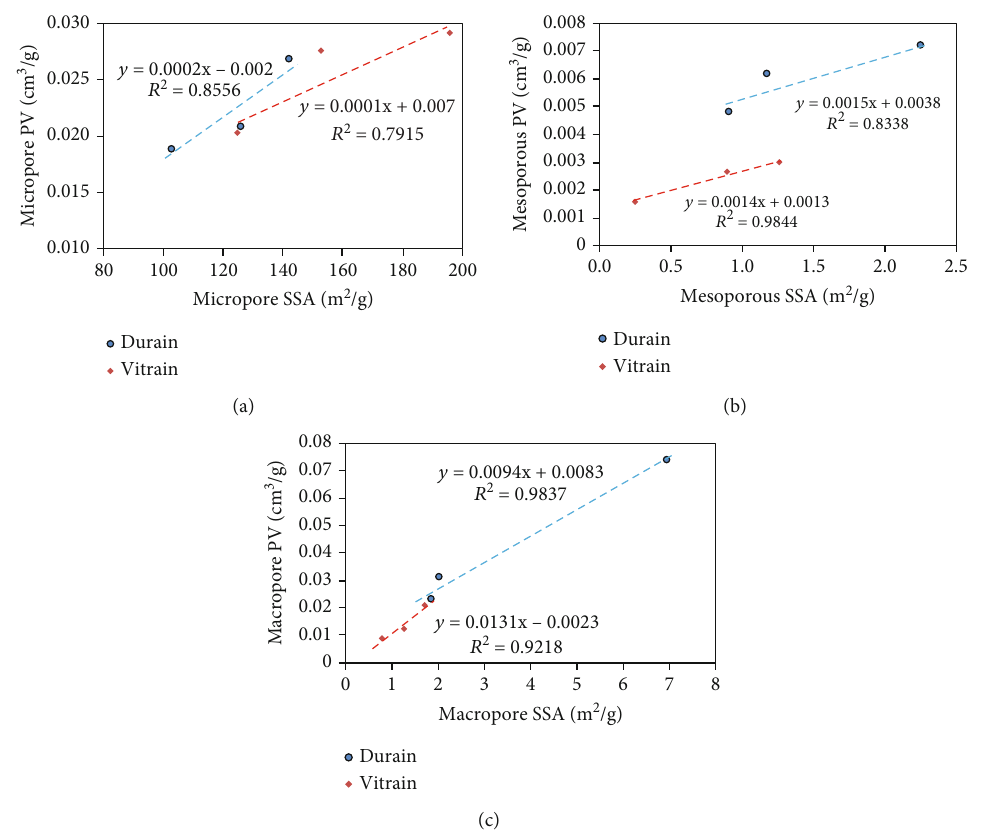
Figure 11: Correlation between the SSA and PV of vitrain and durain. (a) Micropore; (b) mesopore; (c)